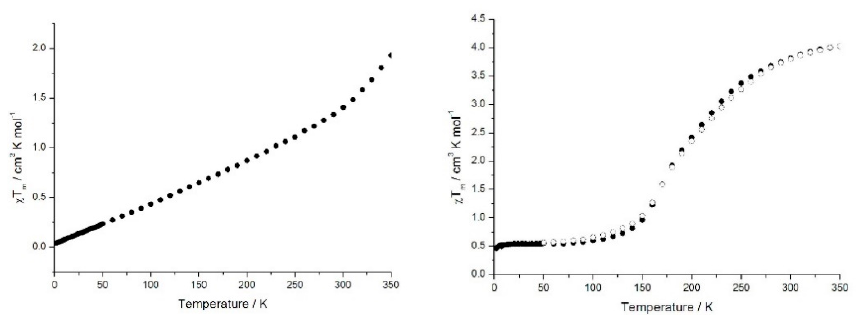
Figure 5. Temperature dependence of the product χ m T for compound 1 ( left ) and compound 2 ( right ). Full circles are measurements of warmings from 2 to 350 K, while open circles are measurements and there is cooling across the same temperature range.